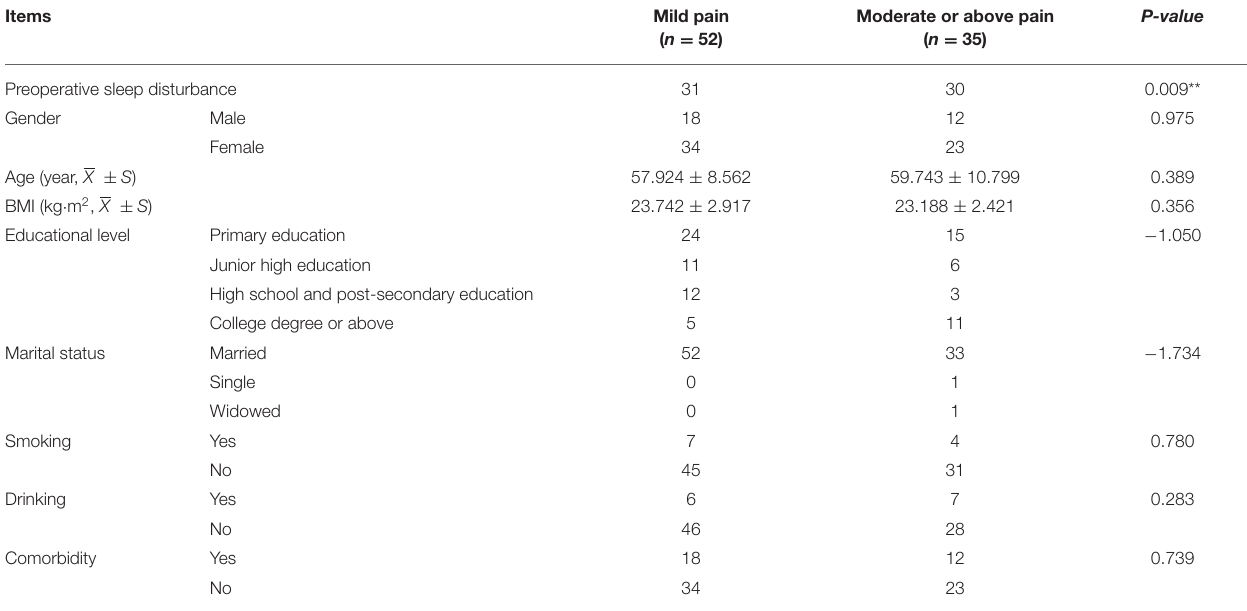
TABLE 4 | Univariate analysis of moderate or above pain at 1 month after surgery ( n =